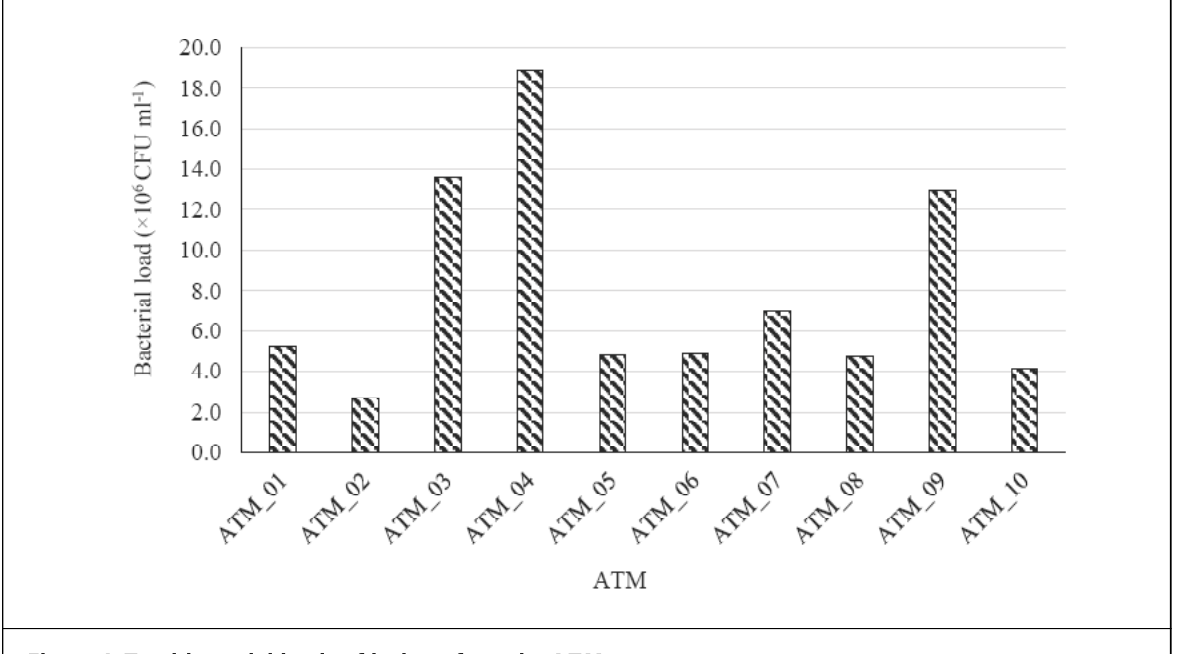
Figure 1: Total bacterial loads of isolates from the